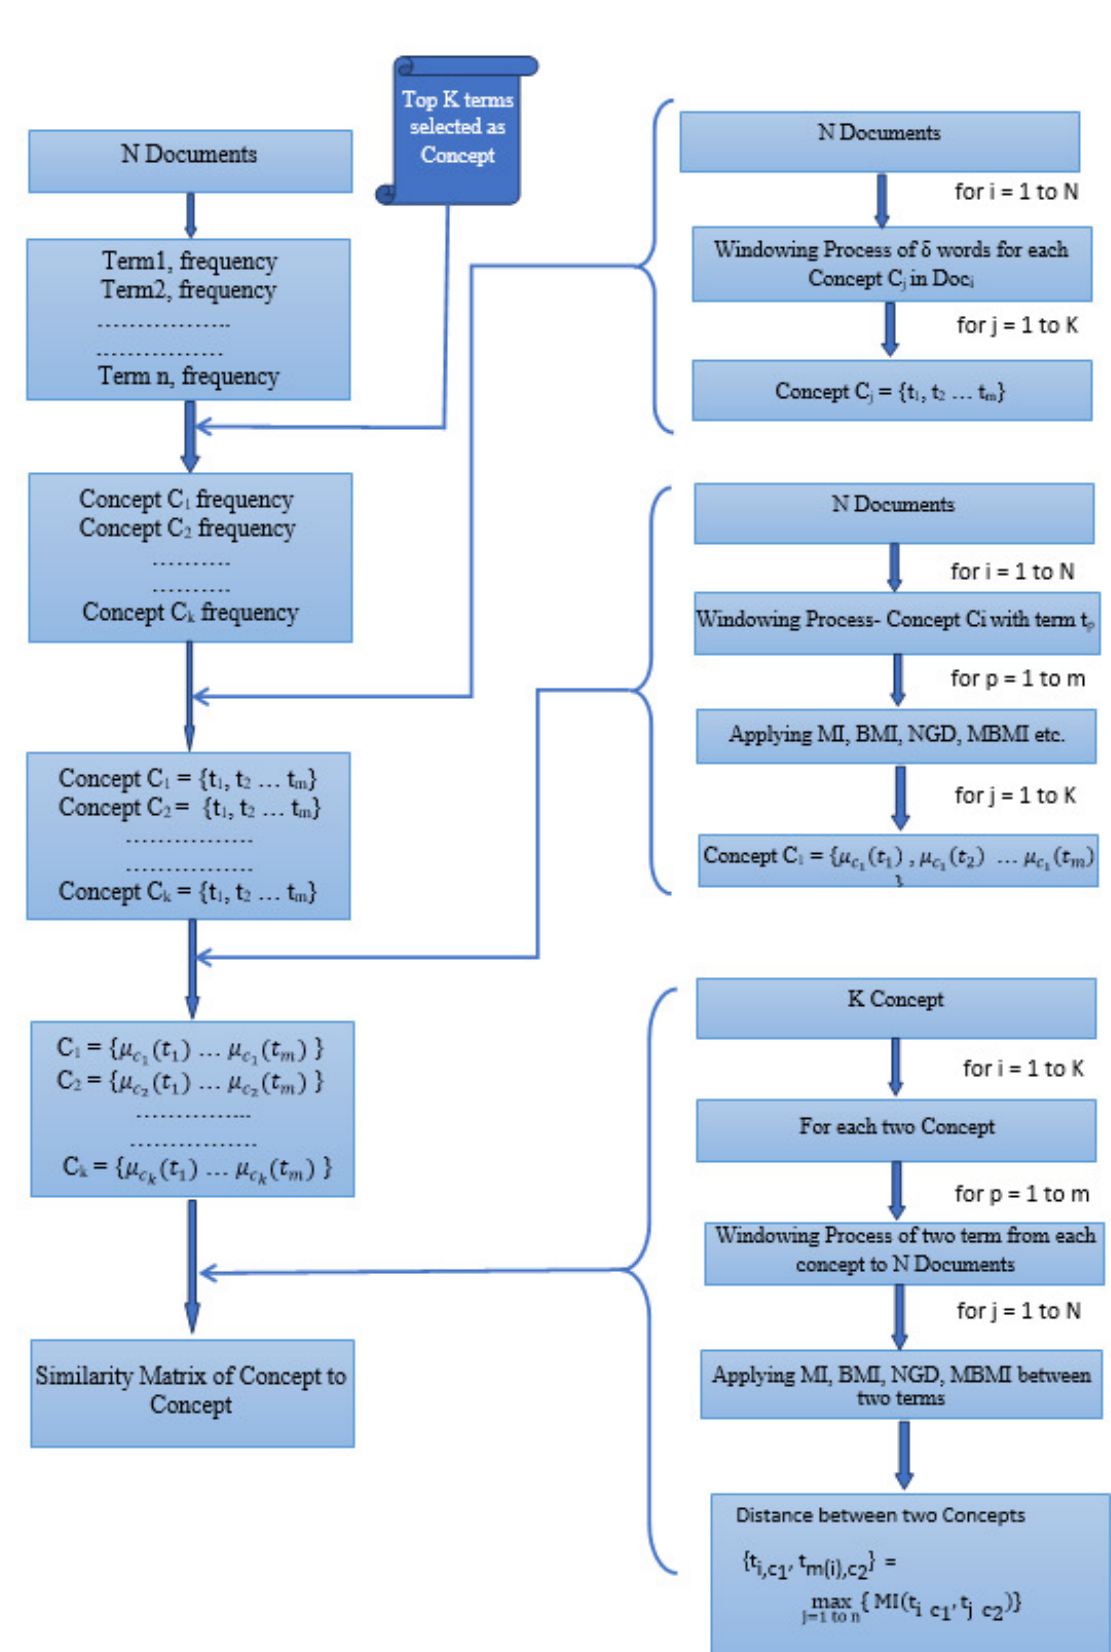
Figure 1. Flow Diagram for Semantic Similarity